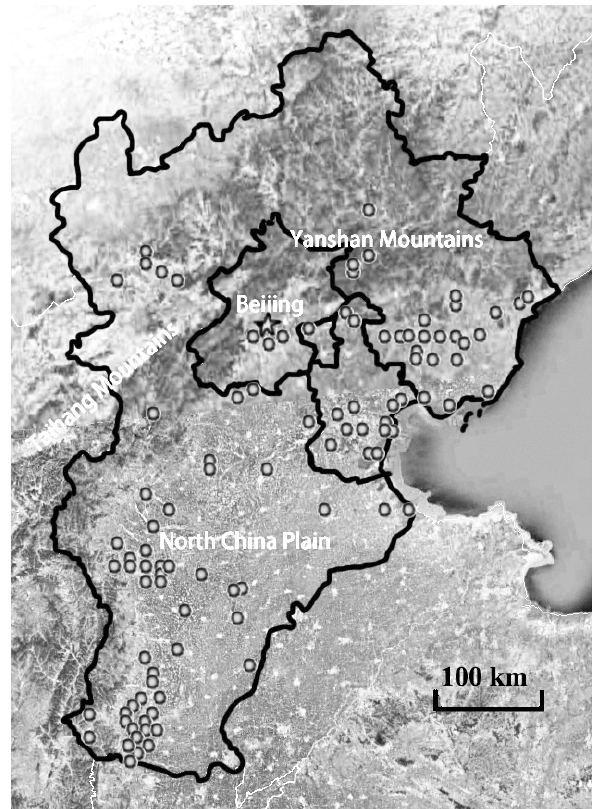
Figure 1. Distribution of thermal power units in the Jing-Jin-Ji Region.